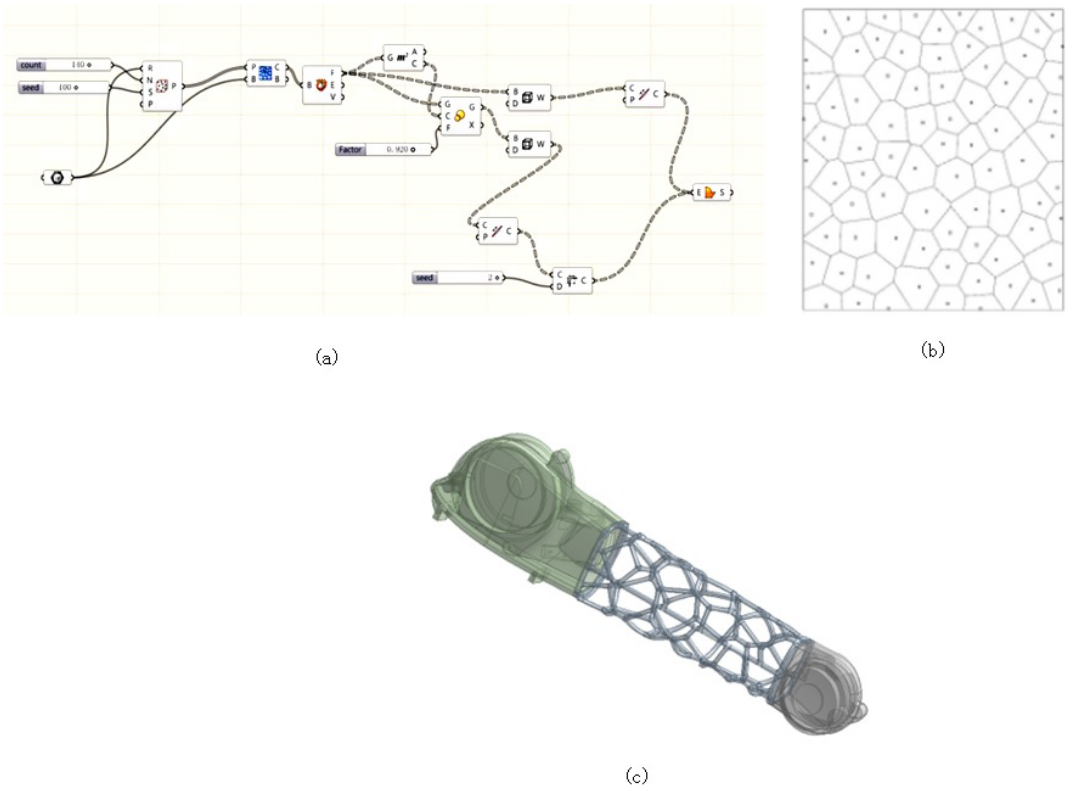
Figure 14. Voronoi structural design of nested external removal: (a) procedural process; (b) Voronoi diagram random points; (c) Voronoi diagram mechanical arm model.